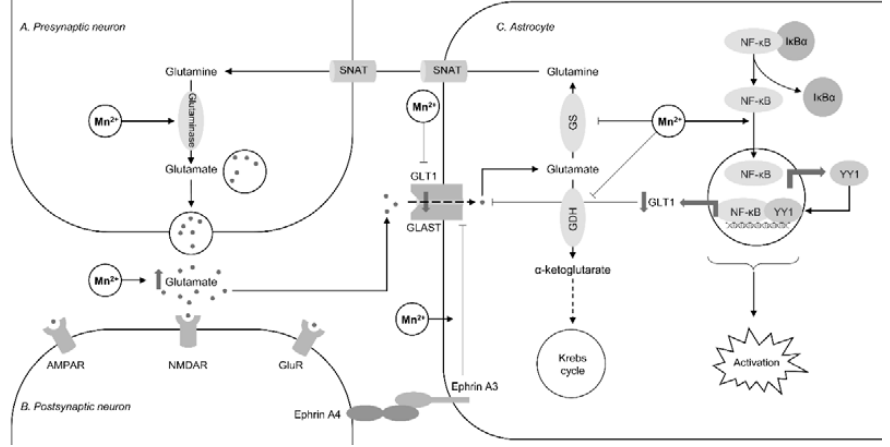
Figure 4. The impact of manganese overexposure on glutamate-glutamine cycle. Manganese ex- posure results in a significant increase in glutamate levels through down-regulation of glutamine synthetase (GS) [179] and glutamate dehydrogenase (GDH) [182] along with up-regulation of glutam- inase [179]. These effects result in reduced glutamate-to-glutamine conversion as well as glutamate cyte glutamate uptake results from inhibition of glutamine transporters (GLT1 and GLAST). Recent studies demonstrated that this inhibitory effect may be mediated through NF- κ B-dependent acti- vation of Yin Yang 1 (YY1) transcription factor [173] and ephrin A3 [178]. It is also notable that Mn-induced NF- κ B signaling also plays a significant role in astrocyte activation associated with reduced glutamine synthetase activity